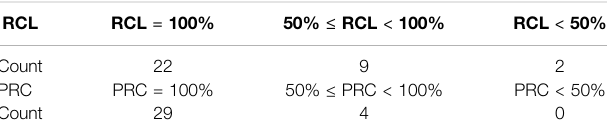
TABLE 3 | The distributions of PRC and